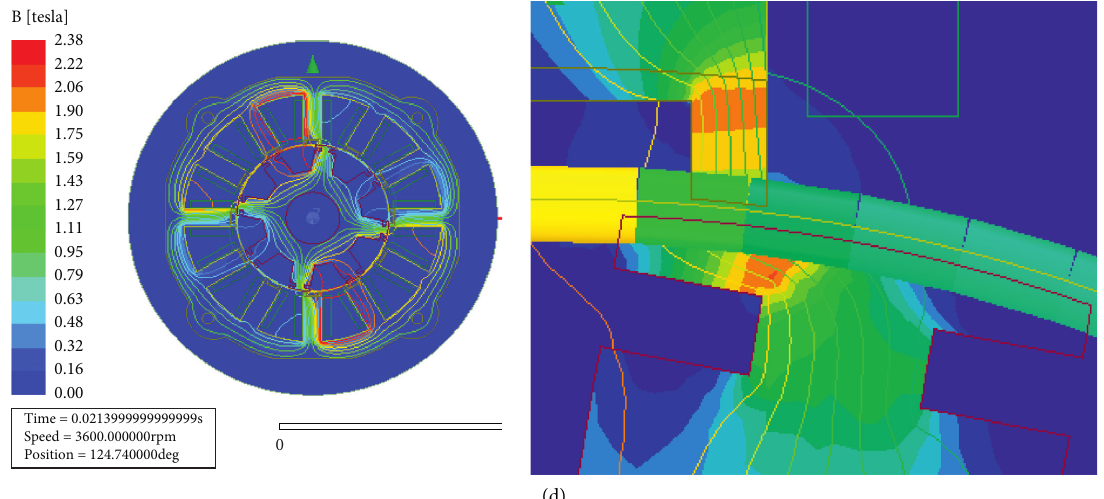
Figure 2: The distribution contours of magnetic induction and magnetic flied line. (a) No auxiliary slots. (b) Stator with auxiliary slots. (c) Rotor with auxiliary slots. (d) Double auxiliary slots.